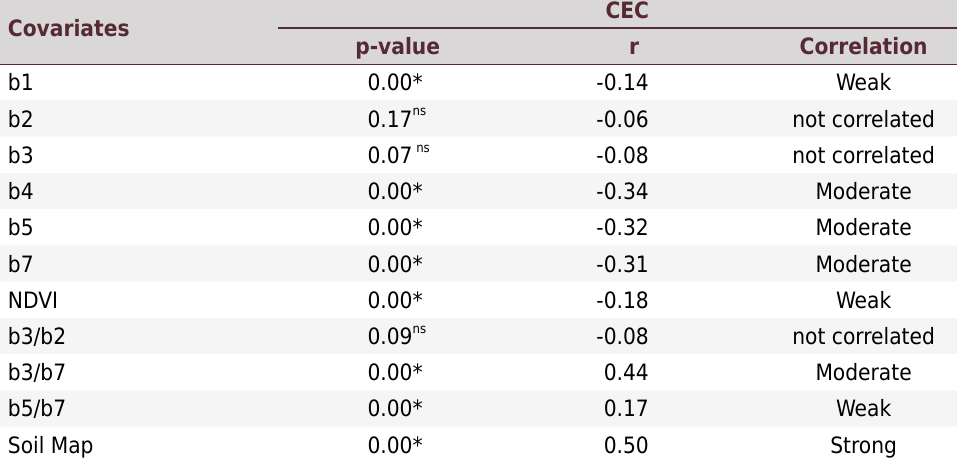
Table 2. Pearson’s correlation between the cation exchange capacity (CEC) and the environmental covariates CEC Covariates p-value r